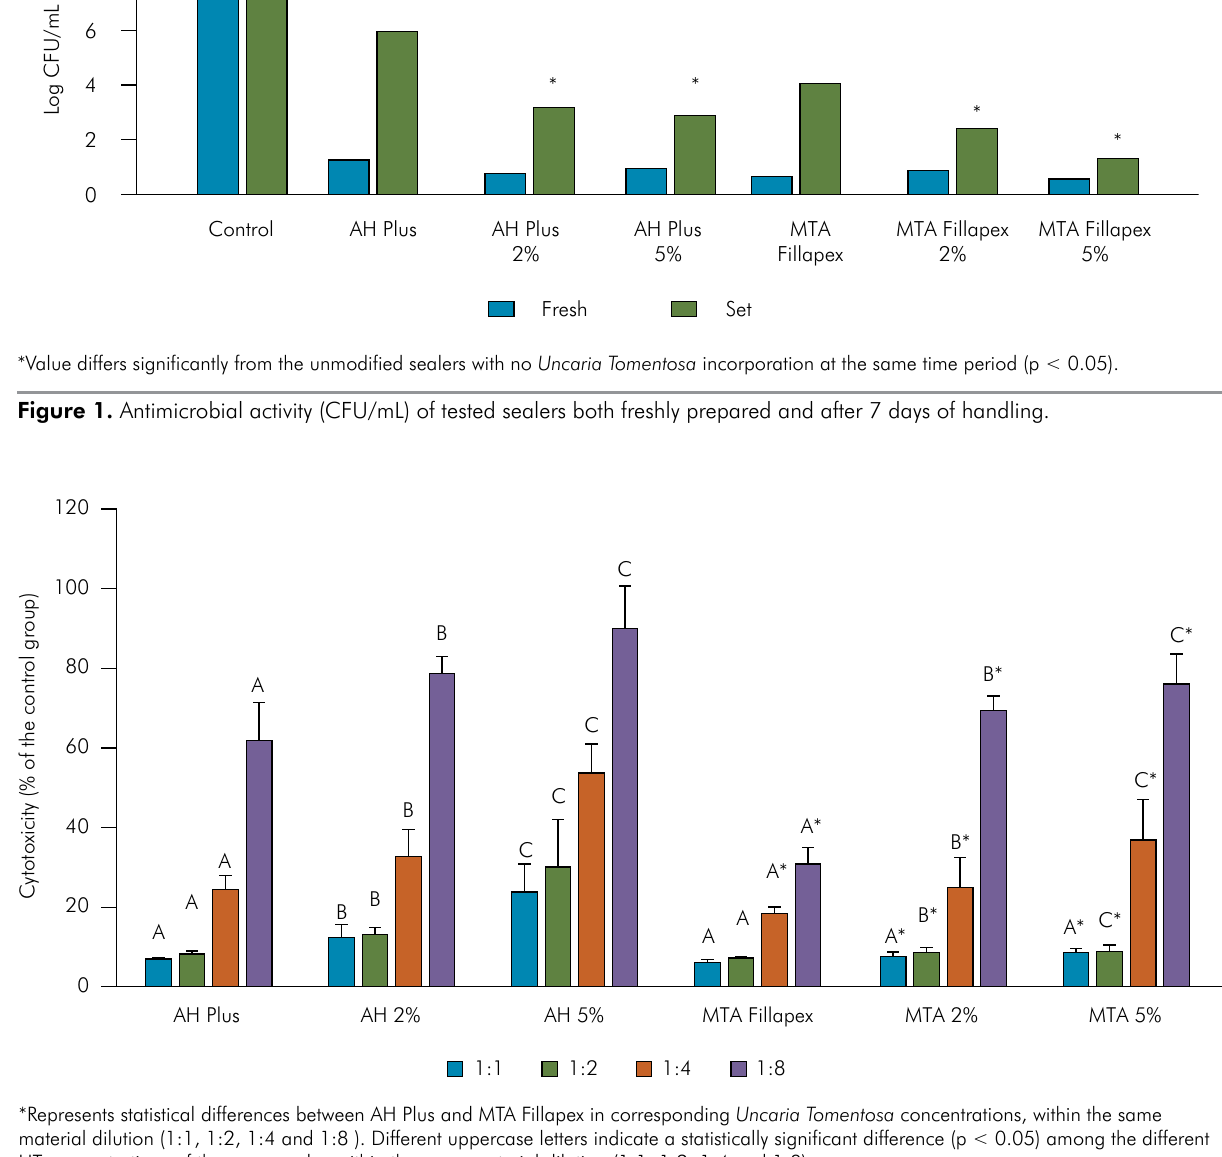
Figure 2. Cytotoxic results after exposure of fibroblast cells to tested sealers. Results are expressed as mean and standard deviation at different dilution percentages.